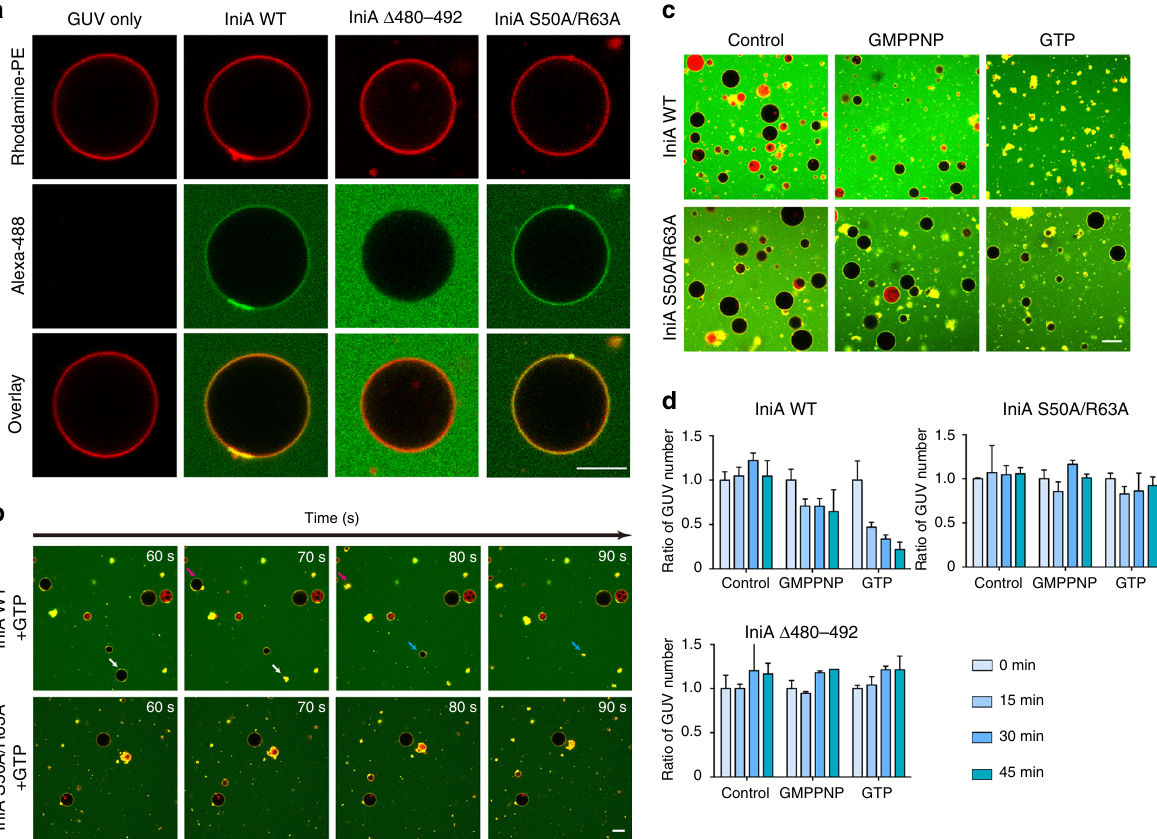
Fig. 5 GUV rupture by IniA. a In vitro GUVs (red) binding assays show different binding ability of 15 µ M WT IniA, Δ 480 – 492, and S50A/R63A mutants (green). Scale bar, 10 µ m. b As shown in ( a ), WT IniA and S50A/R63A mutant with the time course after 0.5 mM GTP/GMPPNP incubation for 10 min, the arrows indicate the rupture sites. Scale bar, 10 µ m. c GUVs treated with 15 µ M WT IniA and S50A/R63A mutant in the presence of 0.5 mM GTP/GMPPNP during 45 min, untreated GUVs as a control. Scale bar, 10 µ m. d The diagram shows the statistical results in ( c ), the number of GUVs seen at indicated time points was counted and shown as relative values to that at the start point. Each bar is the mean and SD of three measurements. The source data of Fig. 5d is provided in the Source Data fi